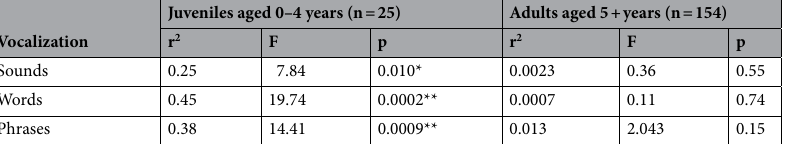
Table 3. Results of linear regressions testing for associations between age and repertoire size in juvenile and adult grey parrots. Repertoires increase with age in young birds, but not in adults. *indicates that regression lines have a slope significantly different from 0 (*p < 0.05, **p < 0.01).